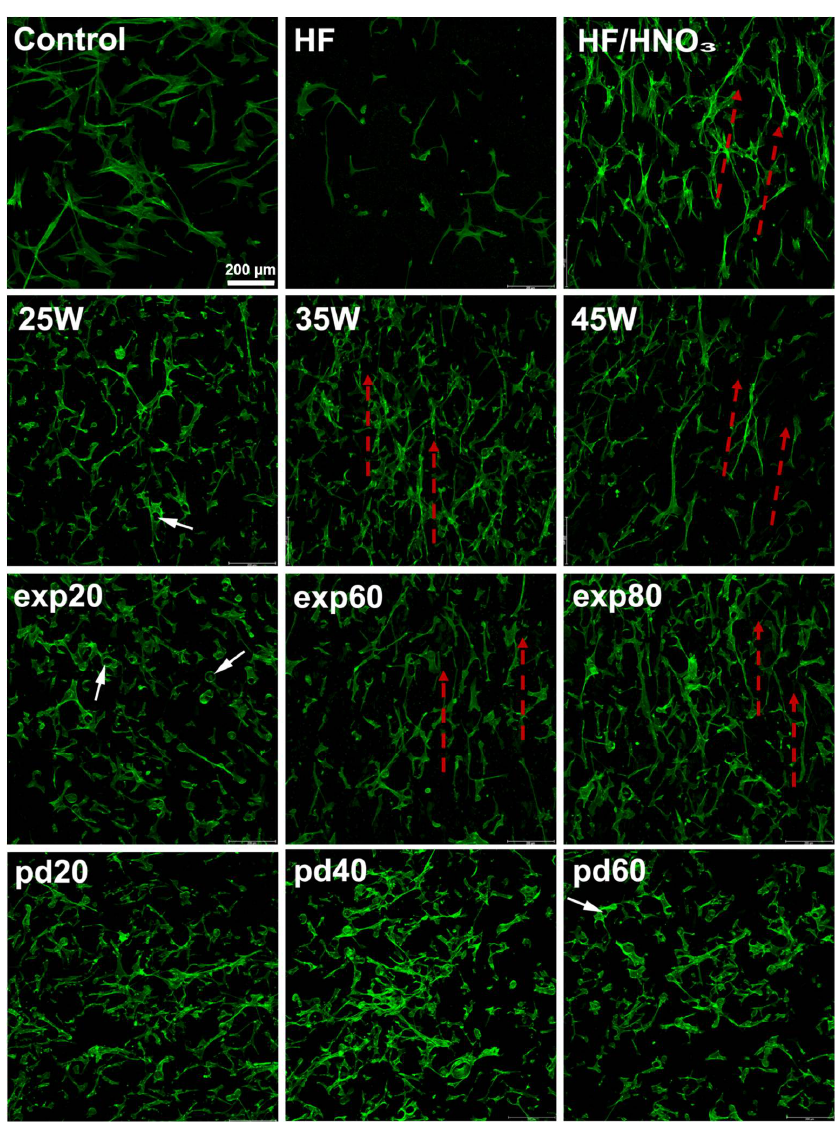
Figure 8. Confocal microscope images of hMSCs spreading after 1 day of culture on the discs fabricated with different laser melting parameters. Cells were stained against F-actin (green). Scale bar of 200 µm.